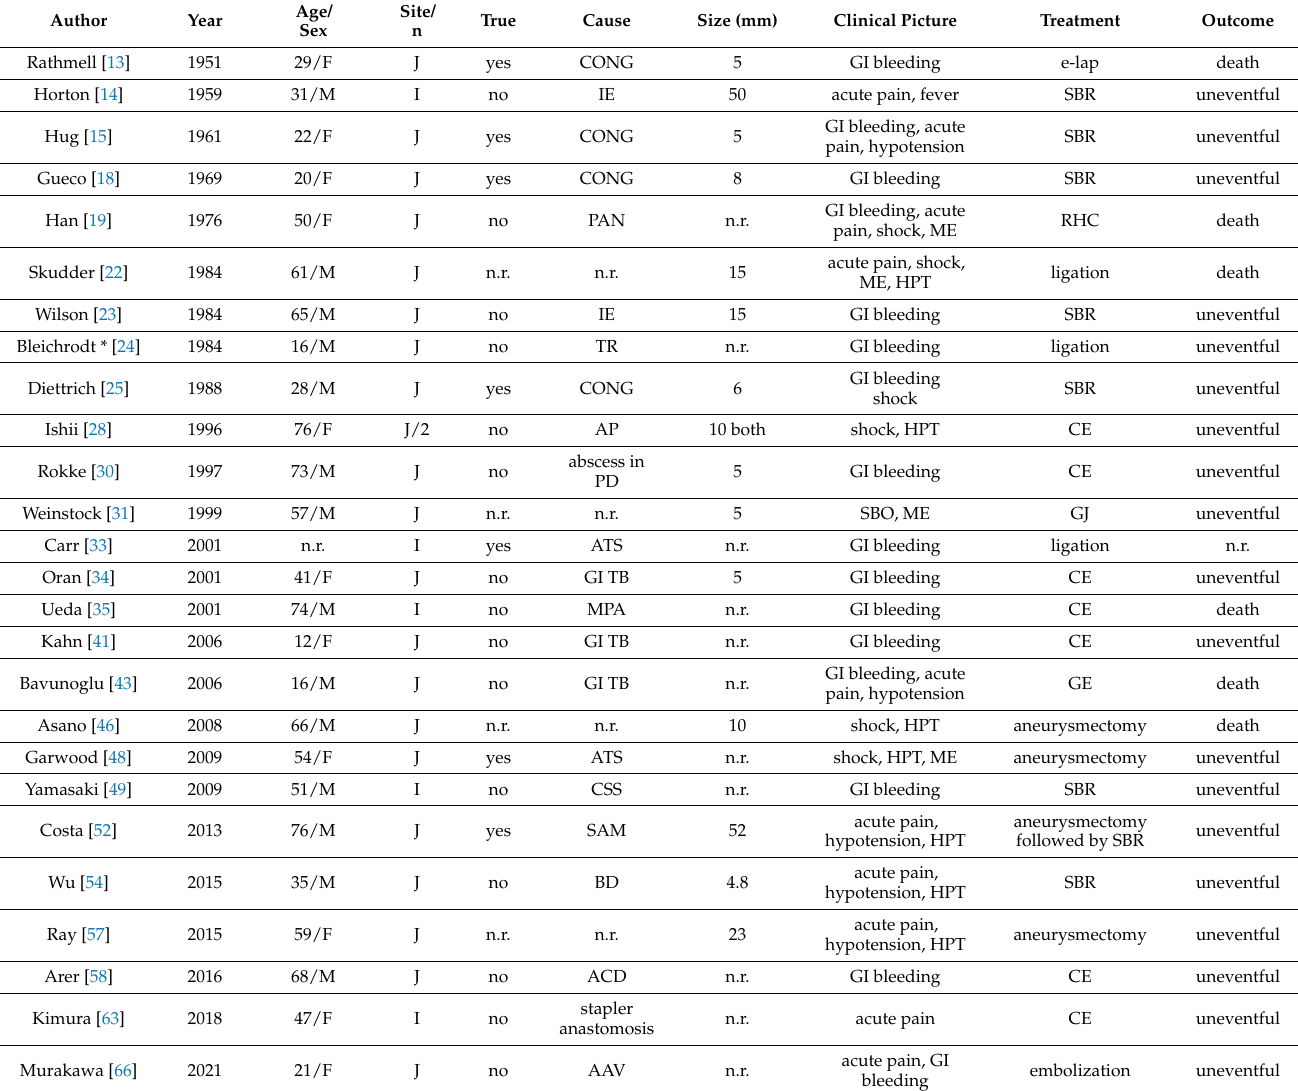
Table 2. Single case reports of ruptured JA and IA